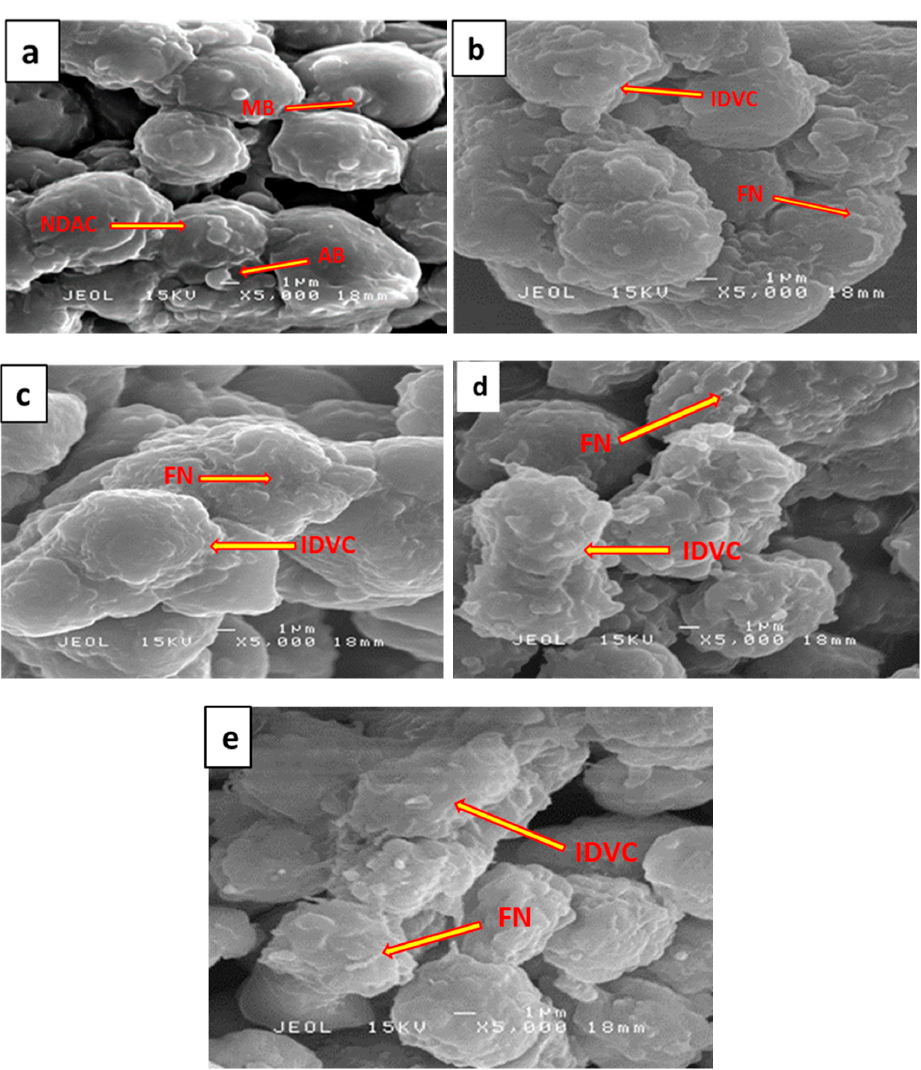
Figure 8. Surface ultrastructural assessment of differentiated SH-SY5Y cells by SEM. ( a ) Cells exposed to H 2 O 2 for 4 h. ( b ) Untreated cells. ( c ) Cells pretreated for 72 h with 2.08 µM 7-geranyloxycinnamic acid. ( d ) Cells pre-treated for 72 h with 2.08 µM 7-geranyloxycinnamic acid and then exposed to H 2 O 2 for 4 h. ( e ) Cells pre-treated for 72 h with 5.97 µM curcumin and then exposed to H 2 O 2 for 4 h. AB = apoptotic bodies, FN = folded neurites, NDAC = neurite disrupted apoptotic cells, IDVC = intact di ff erentiated viable cells, MB = membrane blebbing. Magnification ( ×